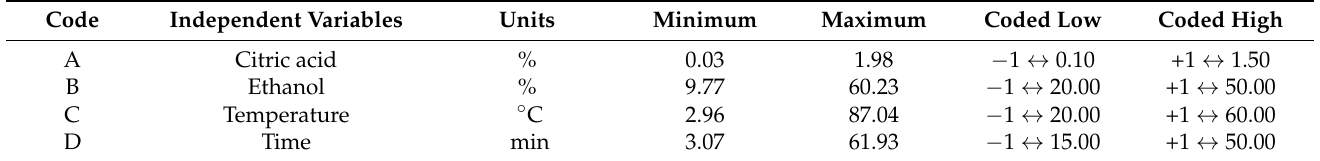
Table 1. Range factors studied and the corresponding encoded